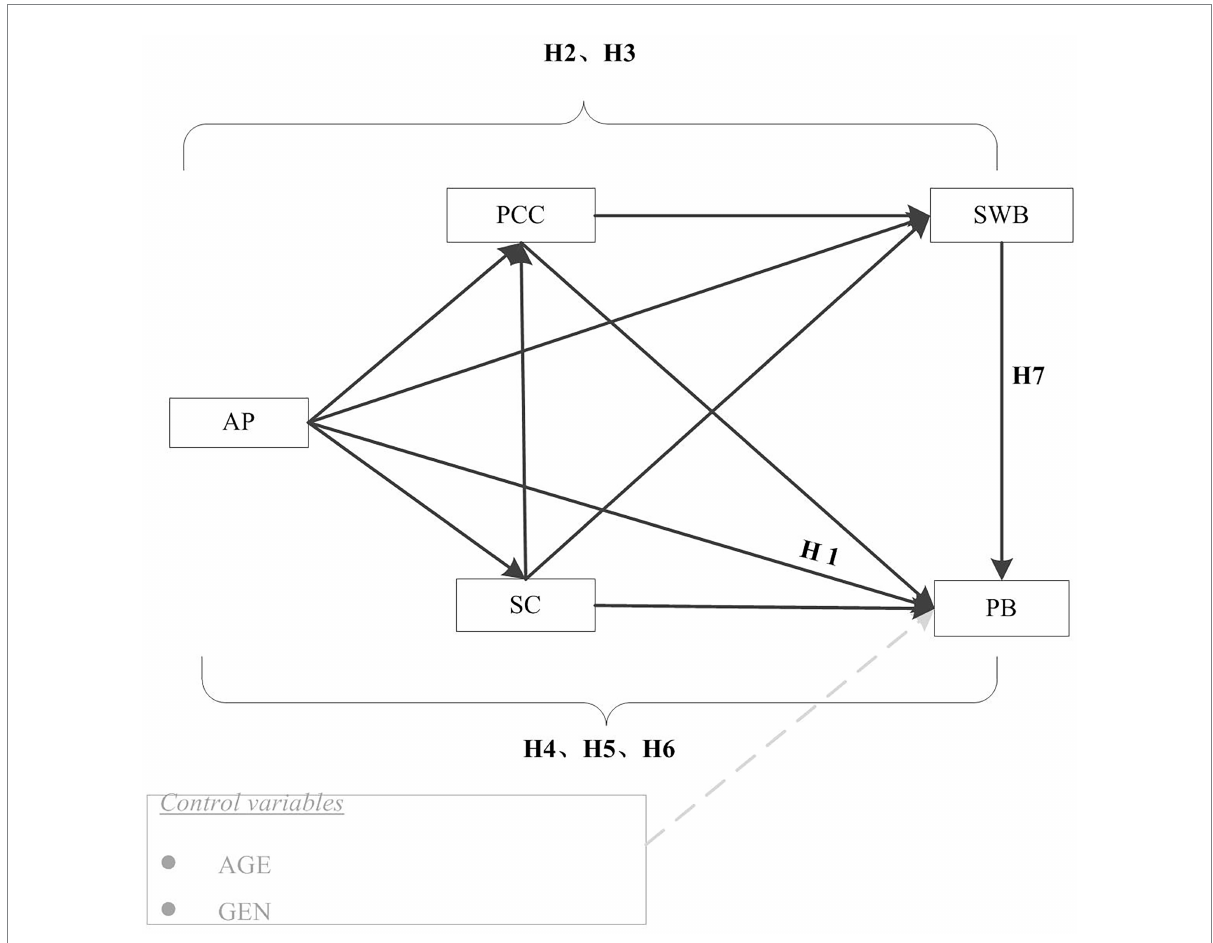
FIGURE 1 Hypothesized model of the research